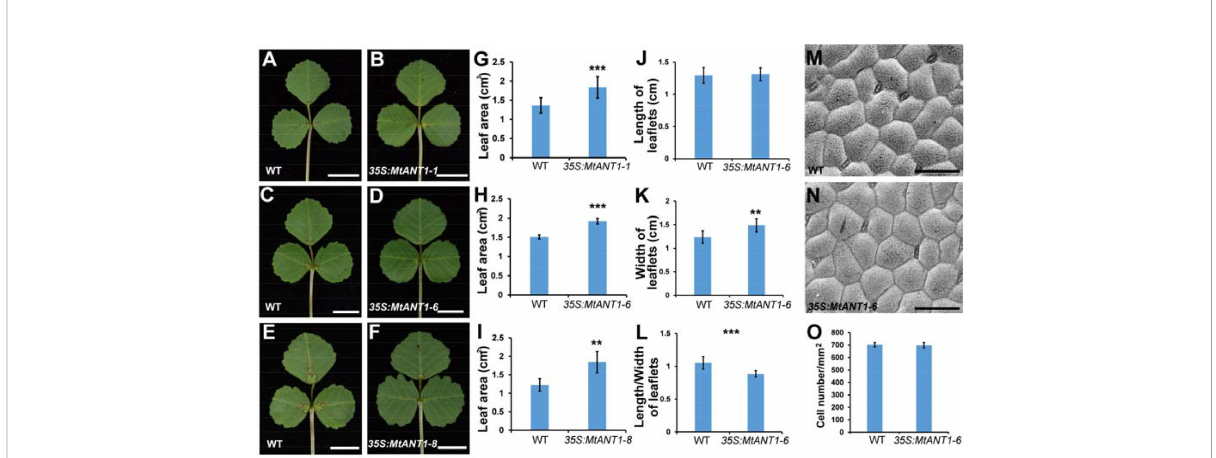
FIGURE 7 Phenotype analyses of leaves in 35S:MtANT1 plants. (A – F) Leaf phenotypes of wild type (A, C, E) and 35S:MtANT1-1 , -6 , -8 transgenic plants (B, D, F) . Bars = 1 cm. (G – I) Leaf area of wild type and 35S:MtANT1-1 , -6 , -8 plants. (J – L) Length (J) , width (K) and length/width ratio (L) of leaves in wild type and 35S:MtANT1-6 plants. (M – N) Scanning electron microscopy analyses of the adaxial surface of leaves in wild type (M) and 35S:MtANT1-6 plants (N) Bars = 50 m m. (O) Cell number per unit area of the adaxial surface of leaves in the wild type and 35S:MtANT1-6 plants. Bars represent means ± SD. ***P < 0.001, **P <